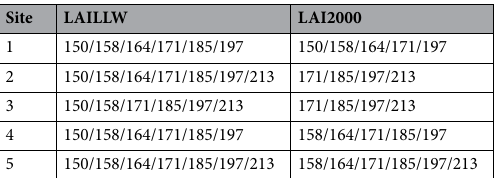
Table 1. The DOY information of data acquisition using the LAILLW and LAI2000.